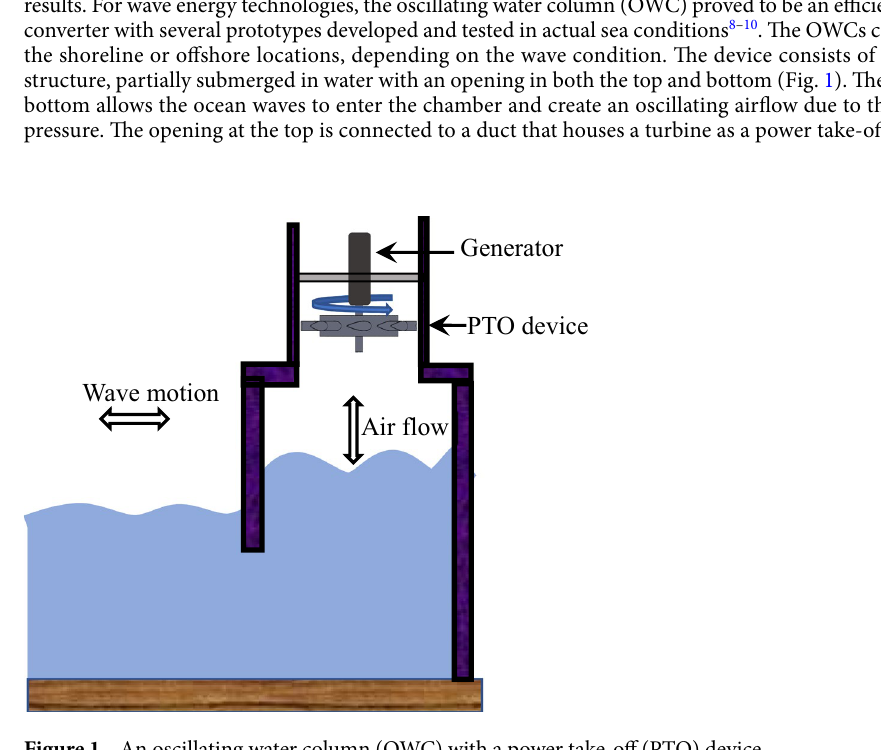
Figure 1. An oscillating water column (OWC) with a power take-off (PTO)